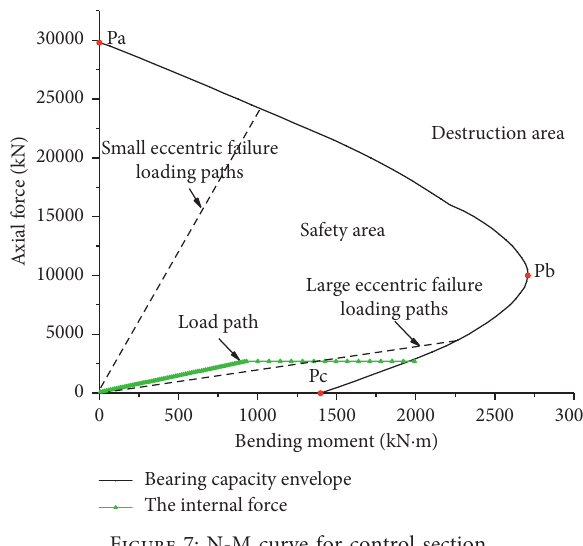
Figure 7: N-M curve for control section.